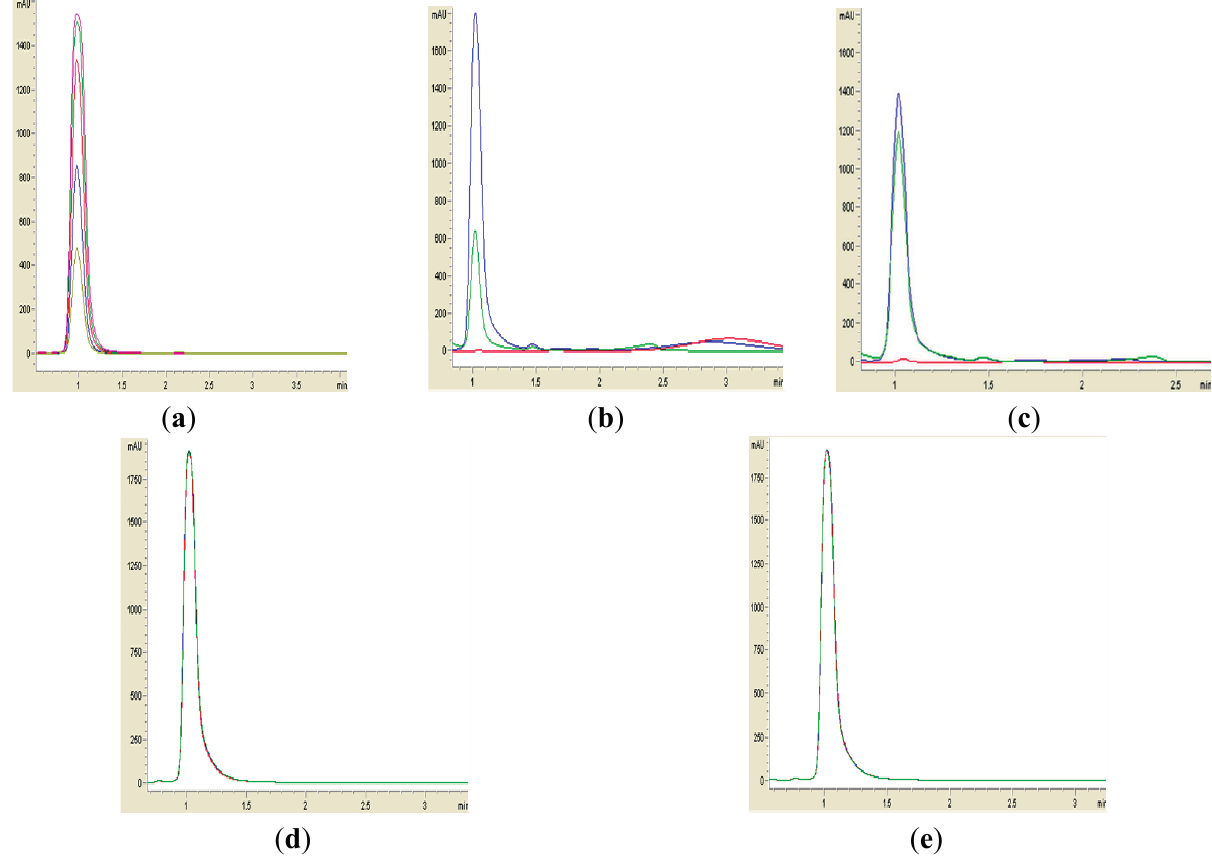
Figure 3. RRLC analysis of 3 - oxo - C6-HSL degradation. Residual 3 - oxo - C6-HSL (with elution time of 1.00 ± 1.2 s), after degradation for 0 h (blue), 24 h (red) and relactonisation with HCl (green), was monitored at OD 210 nm. Degradation of 3 - oxo - C6-HSL was depicted by the reduction of milliabsorbance unit (mAU) in the chromatogram. Samples containing standards 3 - oxo - C6-HSL (0.2 μ g/ μ L, 0.4 μ g/ μ L, 0.6 μ g/ μ L, 0.8 μ g/ μ L and 1.0 μ g/ μ L) (corresponding to peaks with ascending height) ( a ) sample BM1 ( b ), B. cereus acted as positive control ( c ), E. coli Top10 ( d ), PBS buffer acted as the negative controls ( e ). Results show significant degradation and relactonisation of 3 - oxo - C6-HSL by Labrenzia sp.